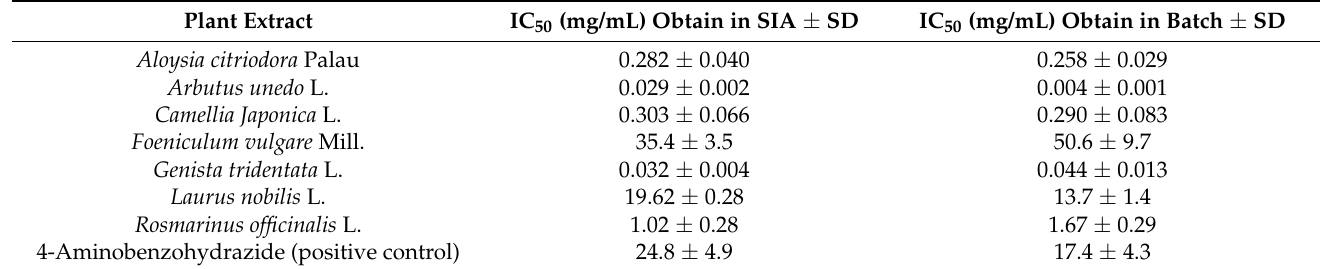
Table 2. Comparison of SIA and BATCH IC 50